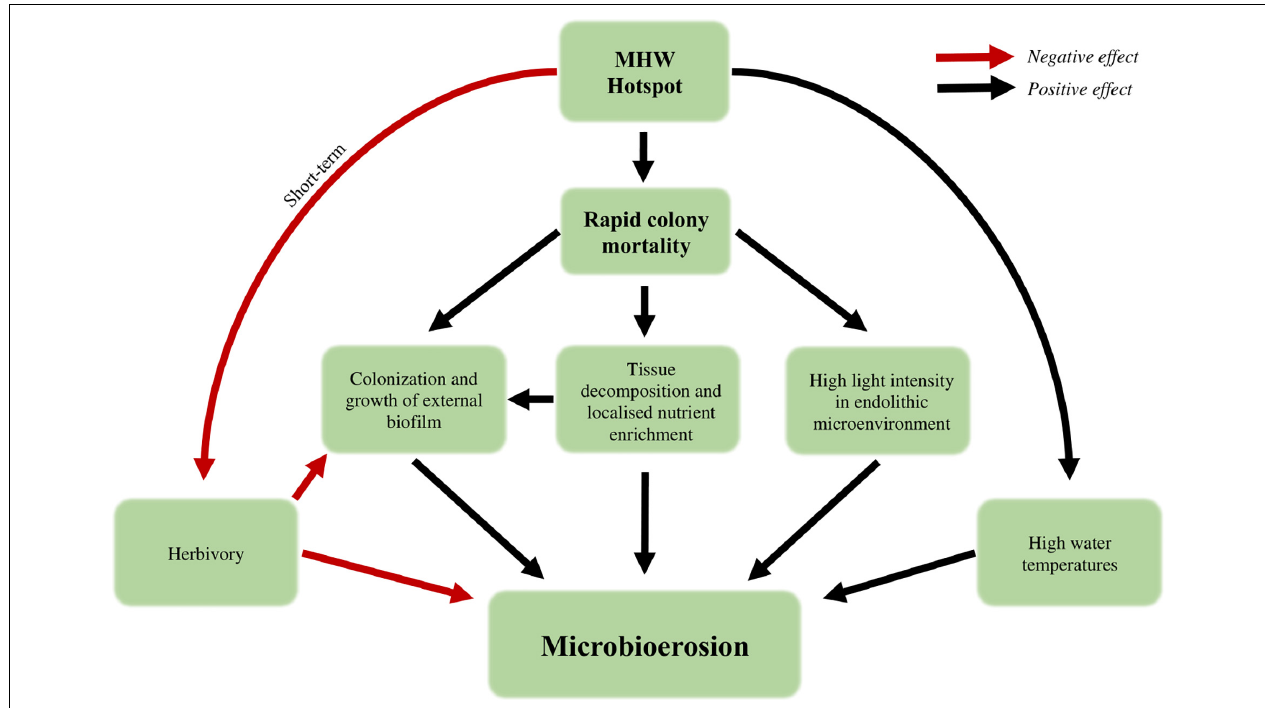
FIGURE 2 | Theoretical combination of abiotic and biotic changes during a marine heatwave that favor accelerated bioerosion by microbial